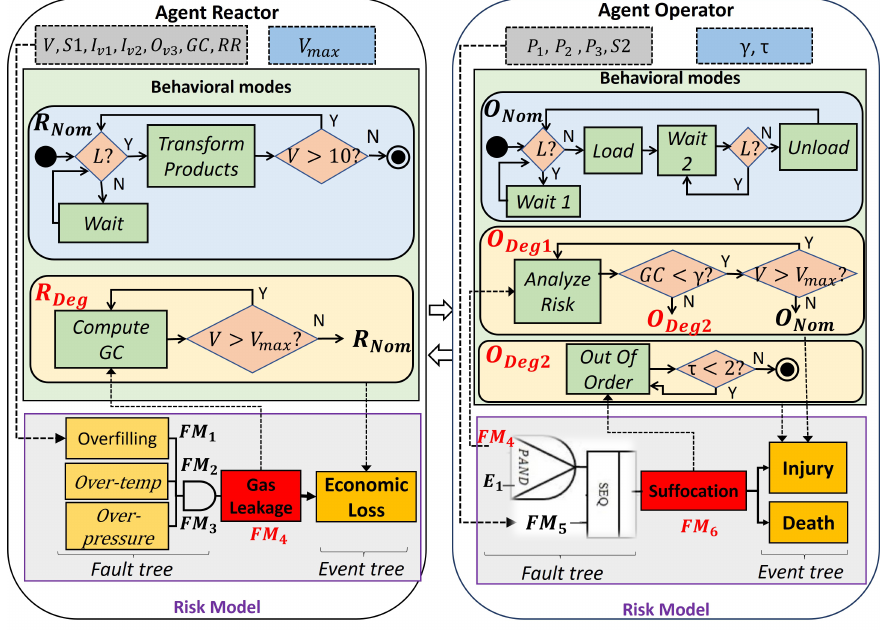
Figure 11. Reactor/Operator with the risk model.